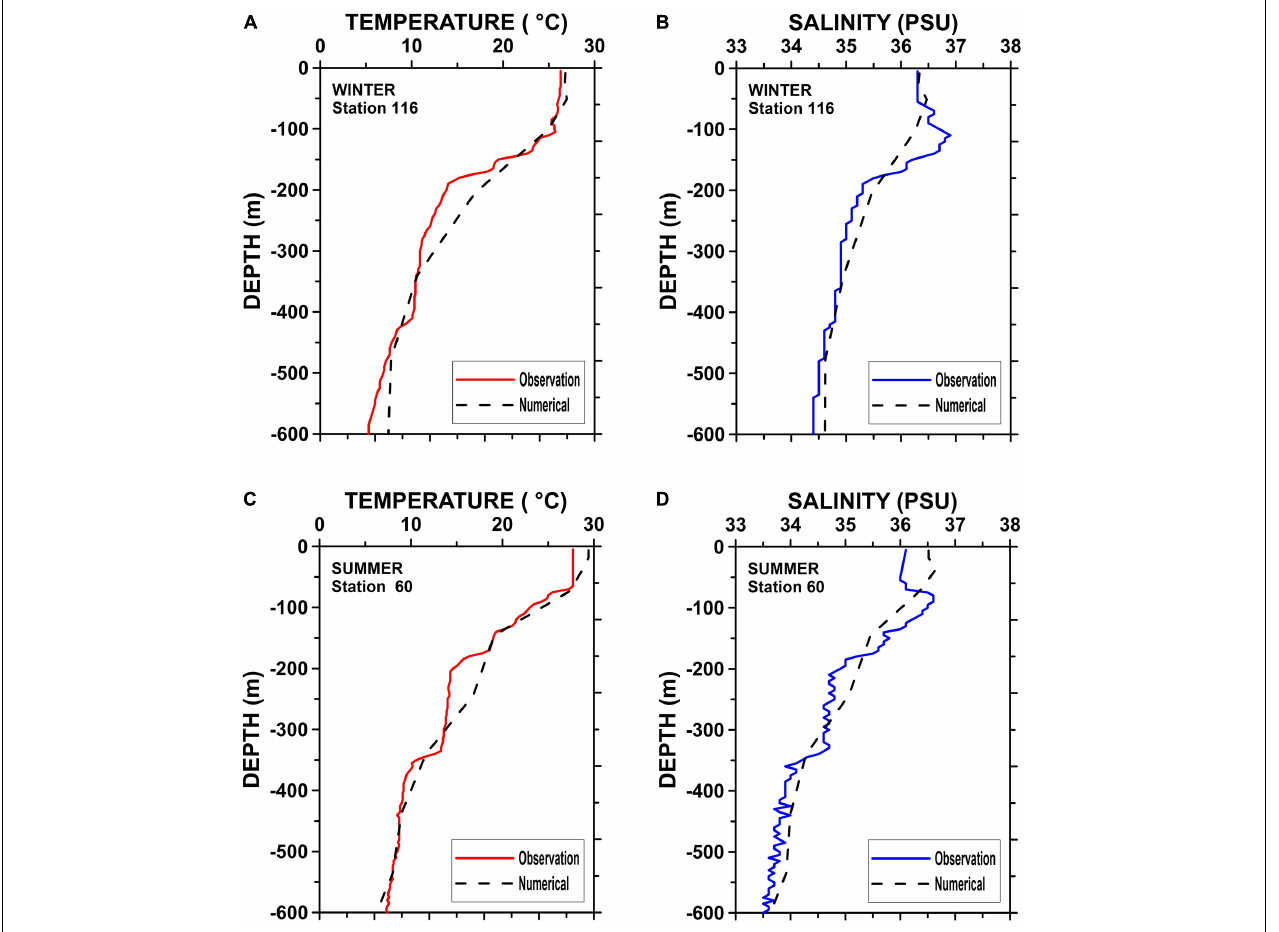
FIGURE 6 | Comparison between experimental data and numerical simulation results for temperature and salinity profiles in the winter (A,B) and summer (C,D)